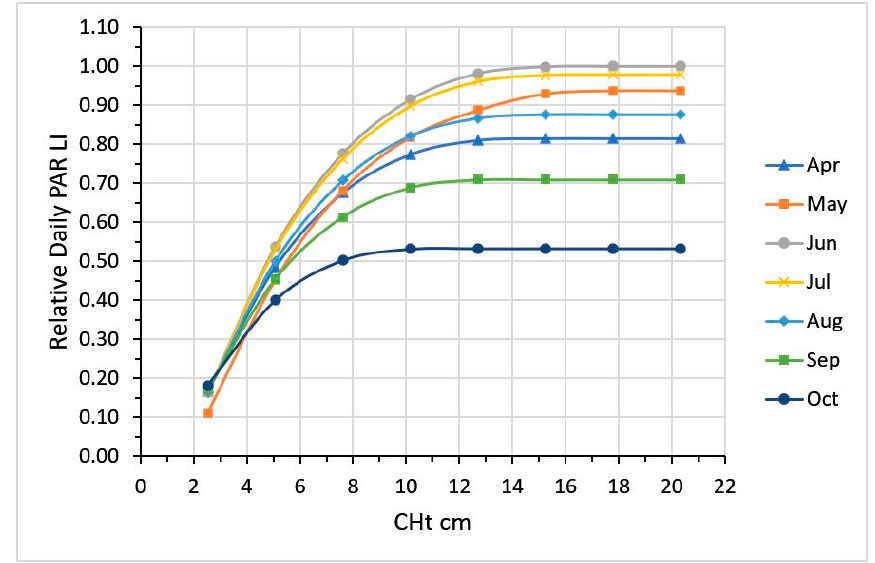
Figure 9. Relative total daily PAR intercepted by pasture canopies di ff ering in plate meter compressed height (CHt, cm) due to solar elevation over the day and daylength at 39° N Lat. height (CHt, cm) due to solar elevation over the day and daylength at 39 ◦ N Table 4. Cumulative probability distribution of the photosynthetically active ration (PAR, µmol of photons m -2 s -2 ) at solar noon in West Virginia being at or below the indicated level (based on 1333 measurements over two years, rounded to the nearest 10 units).